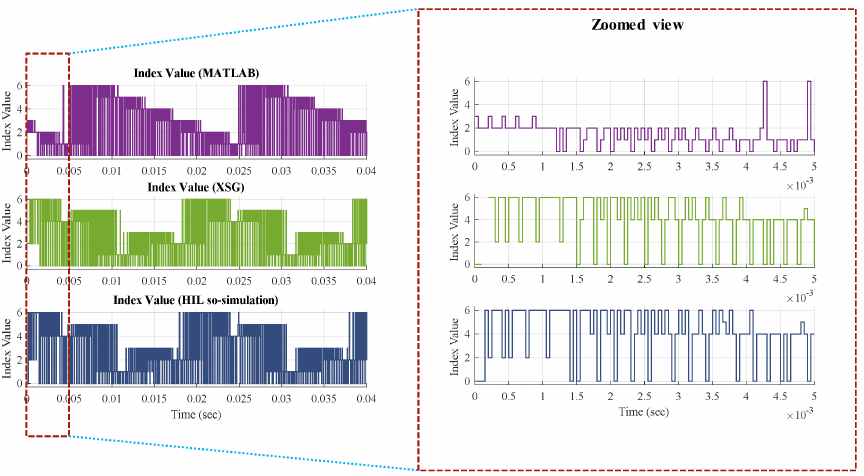
Figure 10. Minimum cost function (g) for every sampling interval obtained using MATLAB/Simulink, XSG, and HIL co-simulation.